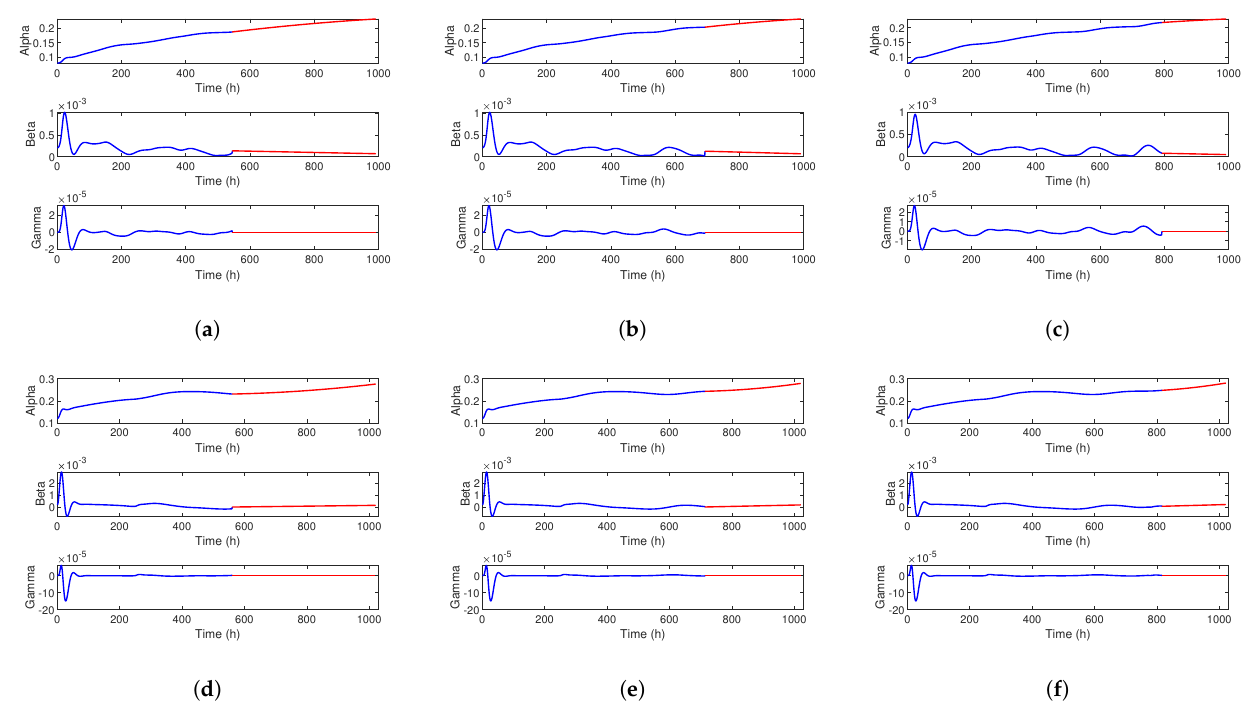
Figure 8. The three-dimensional aging factors of T-AEKF. ( a ) FC1 with 55% training data; ( b ) FC1 with 70% training data; ( c ) FC1 with 80% training data; ( d ) FC2 with 55% training data; ( e ) FC2 with 70% training data; ( f ) FC2 with 80% training